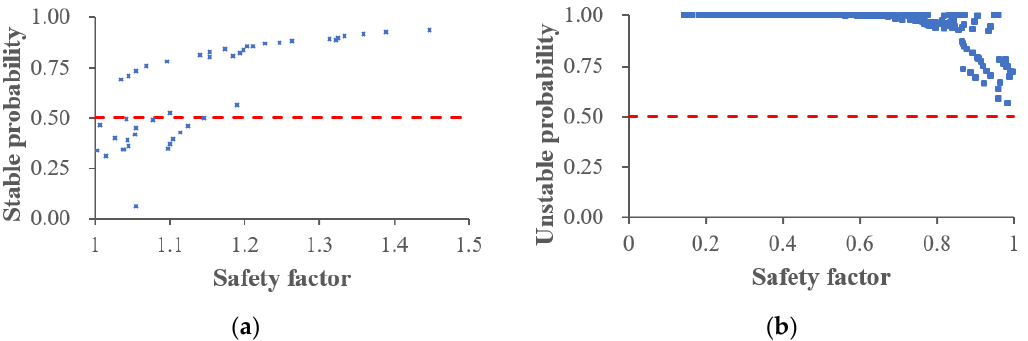
Figure 7. Error estimation for the first classifier. ( a ) Stable probability of the samples with 𝐹 𝑠 ≥ 1 ; ( b ) unstable probability of the samples with 𝐹 𝑠 < 1 .